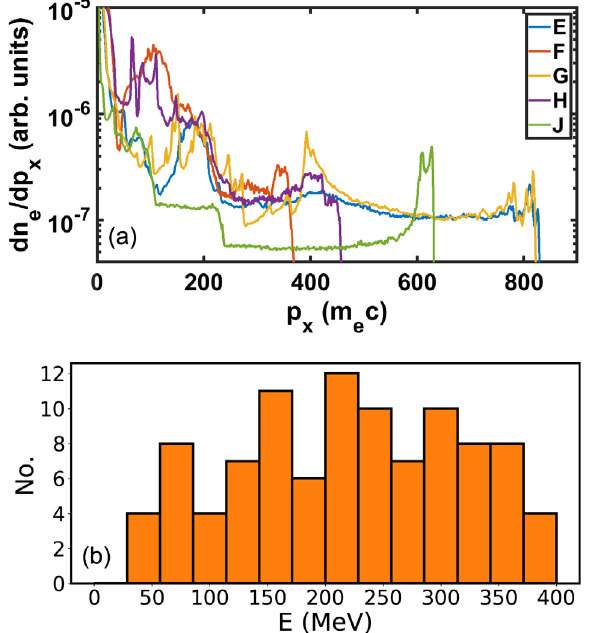
FIG. 8. Panel (a) shows the integrated charge of all particles within the simulation box against the longitudinal momentum for simulations using different laser and cluster parameters. The data was taken after 4.33 ps. Panel (b) shows the final energy of the 100 tracked macroparticles that were injected into the wake in simulation E.